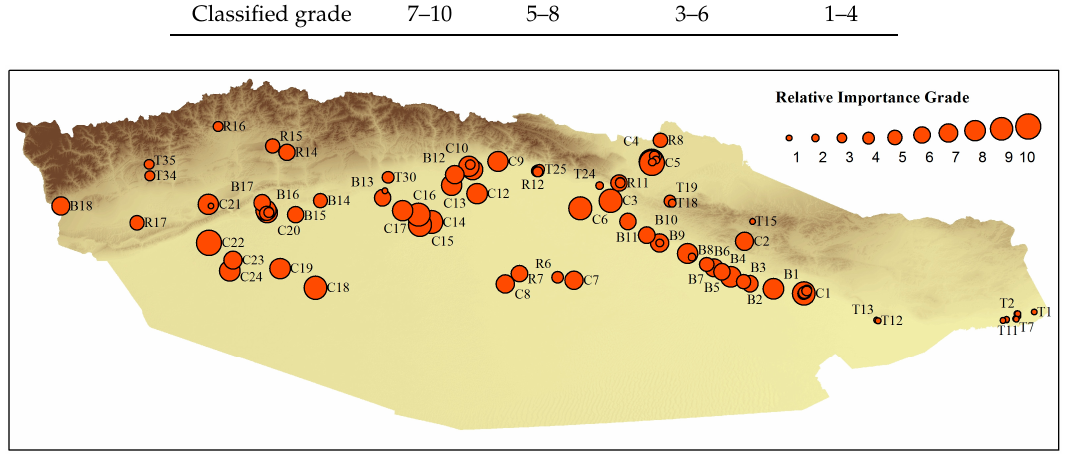
Figure 4. Definition of relative importance grade based on defensive function and site area. Table 4. Classification of relative importance in the defensive system. The importance is ranked in four ranges by the sequence of city, beacon, general relics, and tomb according to the defensive contribution, and then each archaeological type is classified into four grades. Beacon